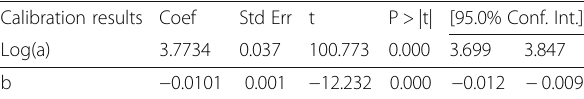
Table 2 Calibration results of exponential function model Eq.(1) for all cities. R 2 = 0.515, sample size N = 147 Calibration results Coef Std Err t P > |t| [95.0% Conf. Int.]